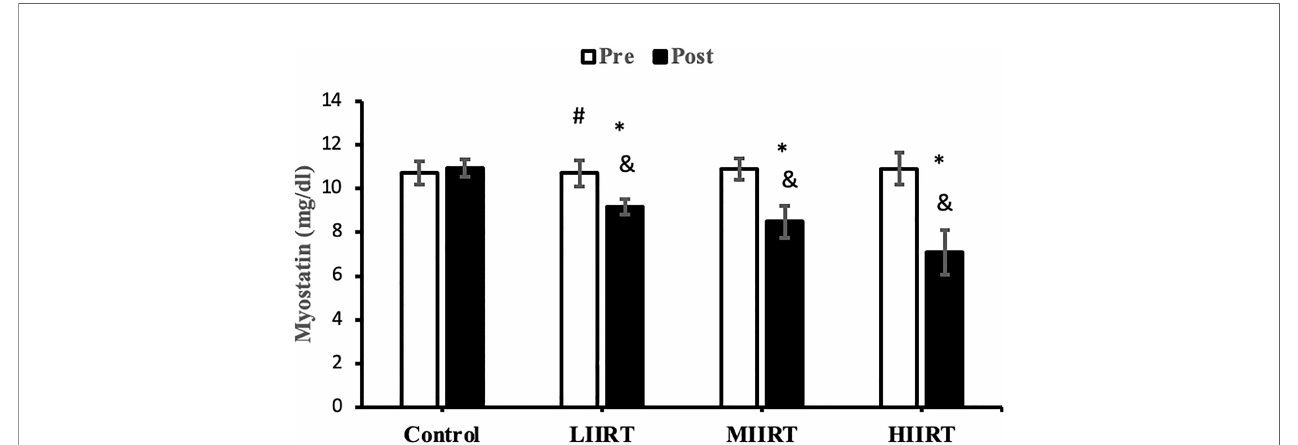
FIGURE 5 | Pre and post-training values (mean ± SD) for myostatin in the control, low-intensity interval resistance training (LIIRT), moderate-intensity interval resistance training (MIIRT), high-intensity interval resistance training (HIIRT) groups. *Signi fi cant differences from the control group (p<0.05). & Signi fi cant differences from pretest values (p<0.05). # Signi fi cant differences between training groups (p<0.05).